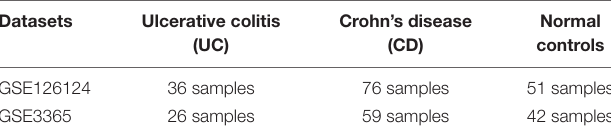
TABLE 1 | Characteristics of the expression profiling microarray datasets GSE126124 and GSE3365 analyzed in this study.